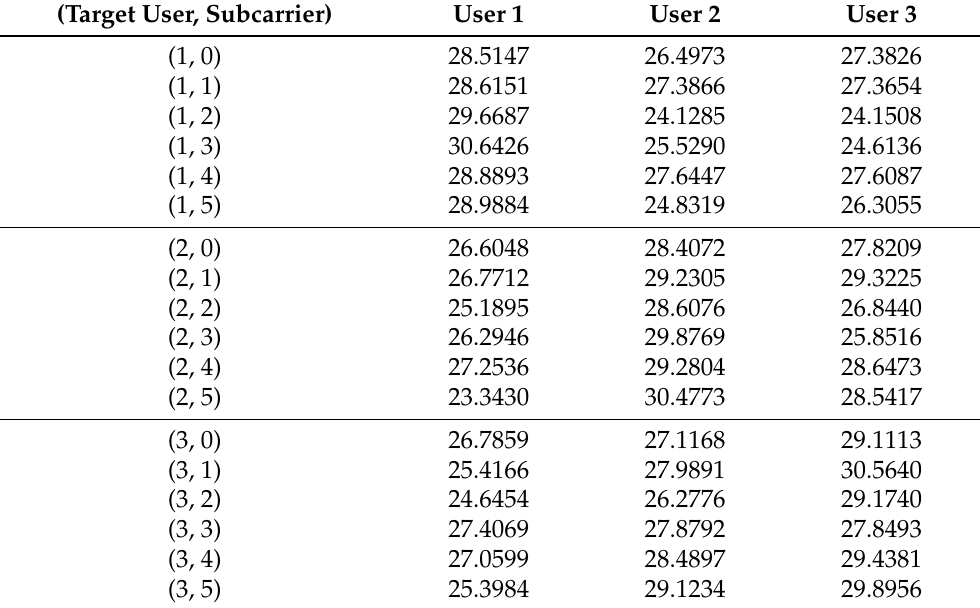
Table 3. A realization of instantaneous rate of every user on every subcarrier with beamforming targeting on each user.